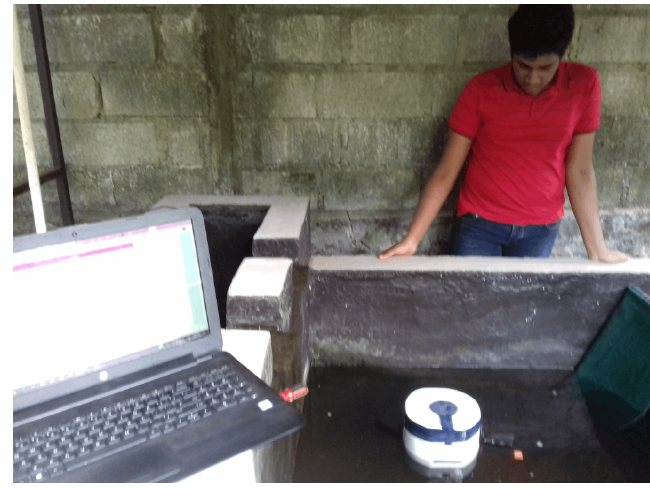
Figure 11. Experimental Setup with a